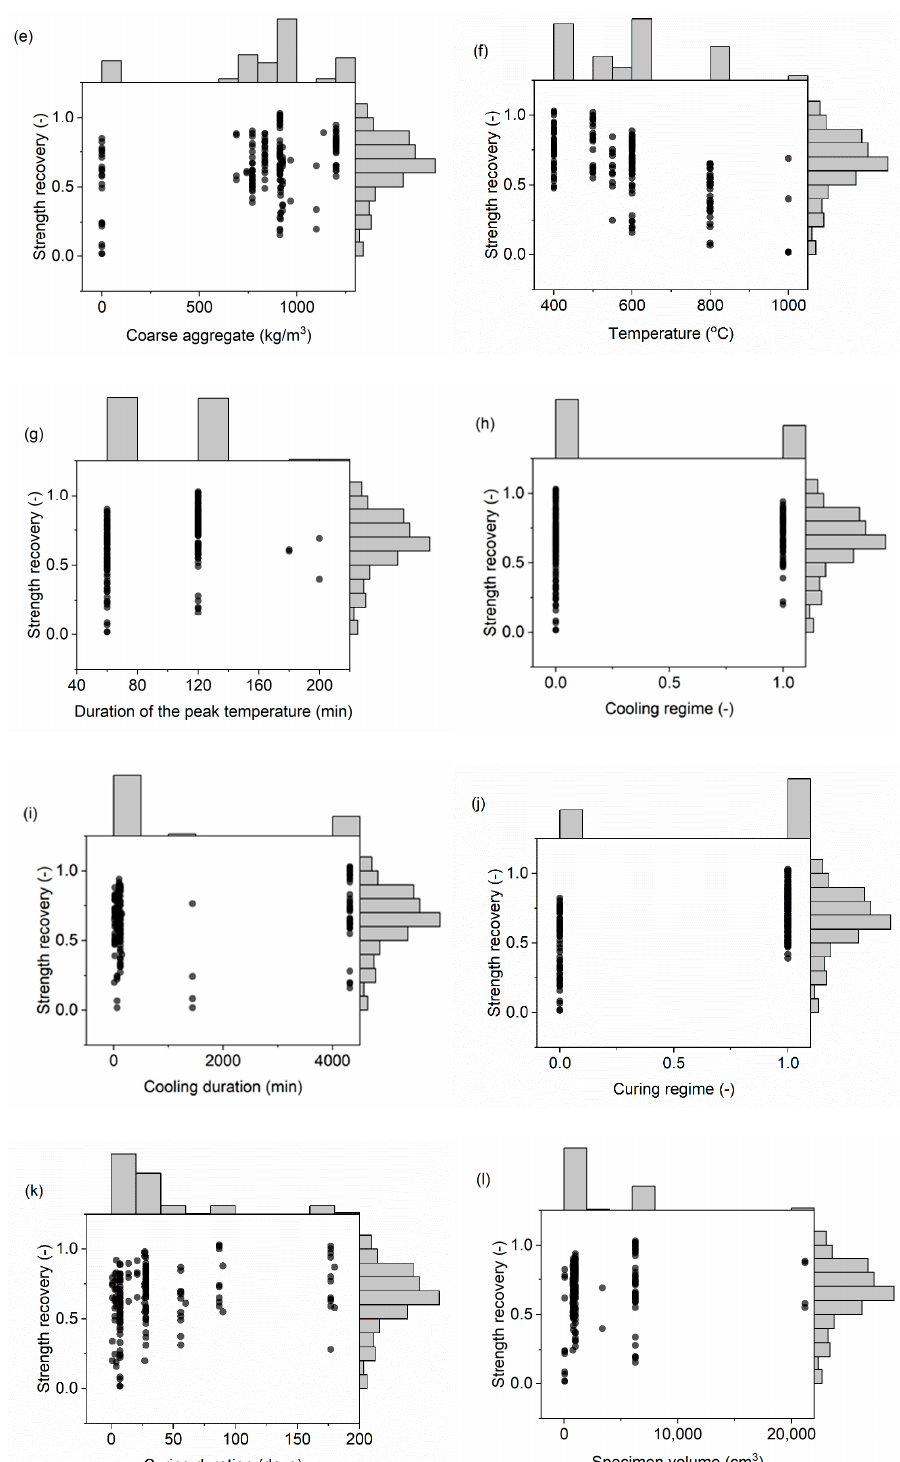
Figure 1. Relationship between the input and output variables, including histograms: ( a ) water-to- cement ratio (I1), ( b ) age (I2), ( c ) cement amount (I3), ( d ) fine aggregate (I4), ( e ) coarse aggregate (I5), ( f ) temperature (I6), ( g ) duration of peak temperature (I7), ( h ) cooling regime (I8), ( i ) cooling duration (I9), ( j ) curing regime (I10), ( k ) curing duration (I11), ( l ) specimen volume (I12).